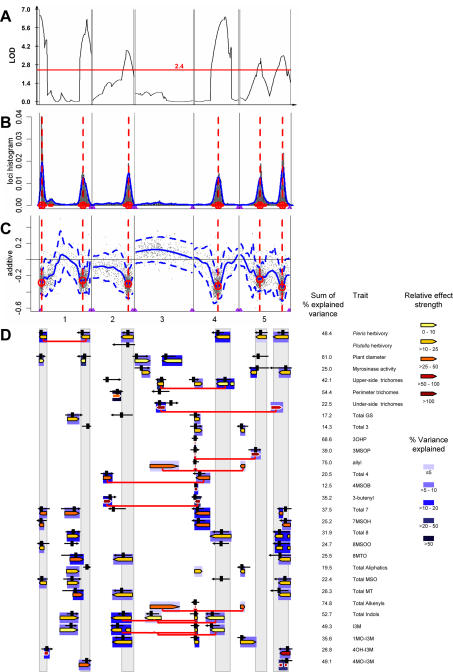
QTL for insect resistance and defense-related traits in Da(1)-12×Ei-2 recombinant inbred lines.A. QTL for resistance against Pieris brassicae, obtained with composite interval mapping (CIM). The horizontal red line indicates the significance threshold for this trait. B. Bayesian interval mapping (BIM) detects the same QTL as CIM. Horizontal red lines indicate high density probability regions in BIM, vertical red lines high density probability peaks. C. Additive effects in BIM, shown as a scatter plot with a smoothing spline fit (solid blue line) plus or minus two standard errors (dashed blue lines). For all six QTL, Pieris larvae cause greater damage when plants carry the Ei-2 alleles at the QTL. Hence, the Da(1)-12 alleles confer higher resistance. D. QTL for resistance against specialist lepidopterans, plant diameter, myrosinase activity, trichome density on the leaf upper and under-sides and perimeter, and for glucosinolates. For glucosinolates, QTL for individual compounds and for sum variables are given. Abbreviations are as follows: 3OHP = 3-hydroxypropyl; 3MSOP = 3-methylsulfinylpropyl; 4MSOB = 4-methylsulfinylbutyl; 7MSOH = 7-methylsulfinylheptyl; 8MSOO = 8-methylsulfinyloctyl; 8MTO = 8-methylthiooctyl; I3M = indol-3-yl-methyl; 1MO-I3M = 1-methoxy-indol-3-yl-methyl; 4OH-I3M = 4-hydroxy-indol-3-yl-methyl; 4MO-I3M = 4-methoxy-indol-3-yl-methyl. Total 3, 4, 7 and 8 are the sums of homomethionine-, di-homomethionine-, penta-homomethionine-, and hexa-homomethionine-derived glucosinolates, respectively. Total MSO, MT, and alkenyls are the sums of aliphatic glucosinolates with methylsulfinyl-, methylthio-, and alkenyl-groups, respectively. Total aliphatics and indoles are the sums of methionine- and tryptophan-derived glucosinolates, respectively, and total GS is the sum of all glucosinolates. Colored arrows correspond to 2-LOD support intervals for QTL identified with CIM, black arrows for high density probability regions in BIM, with vertical black bars showing the position of the high density probability peaks. Arrow directions correspond to effect directions; arrows pointing left indicate that the Ei-2 allele has a stronger effect on a particular trait. Arrow fill colors code for the relative effect strength of a QTL, arrow background colors for R
2, the percentage of variance explained by a QTL. Horizontal red lines connecting colored arrows indicate epistatic interactions between QTL.